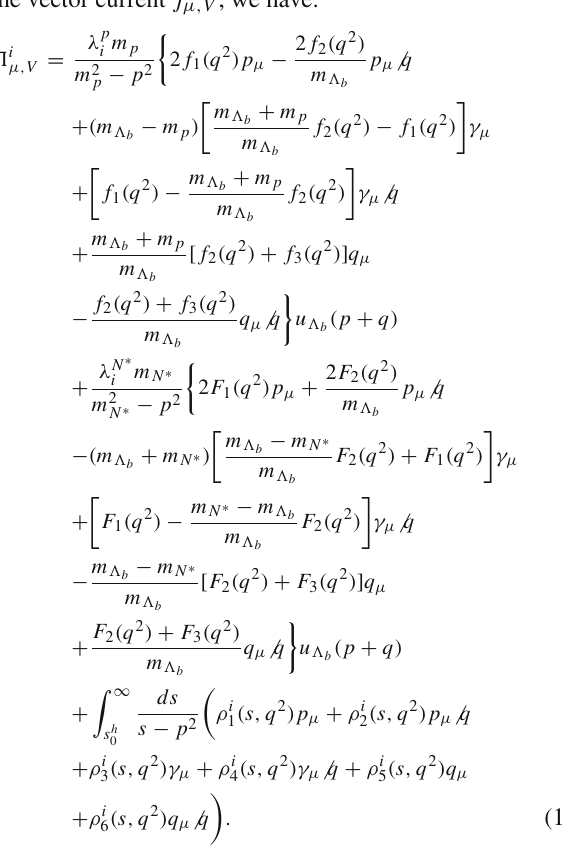
Fig. 1 Diagrammatical representation of the correlation function (cid:14) μ, ( n · p , ¯ n · p ) at tree level, where the black square denotes the a weak transition vertex, the black blob represents the Dirac structure of the N ( ∗ ) -baryon current and the pink internal line indicates the hard- collinear propagator of the u quark